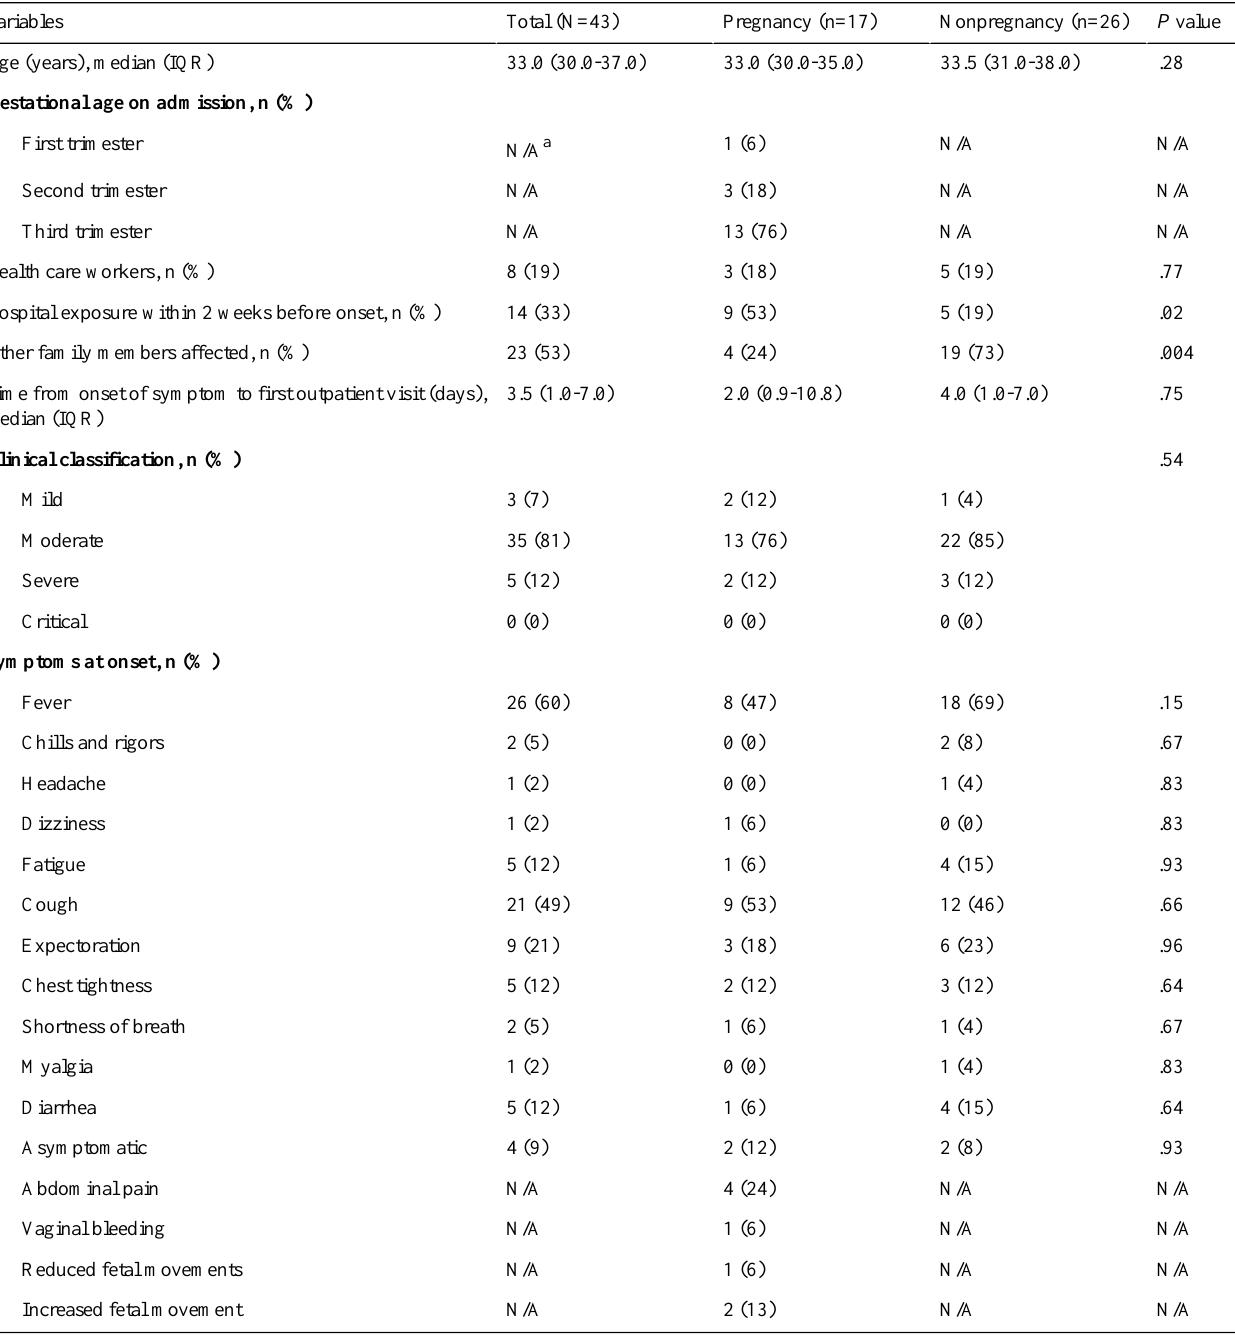
Table 1. Epidemiological and clinical features of pregnant and nonpregnant women with the coronavirus